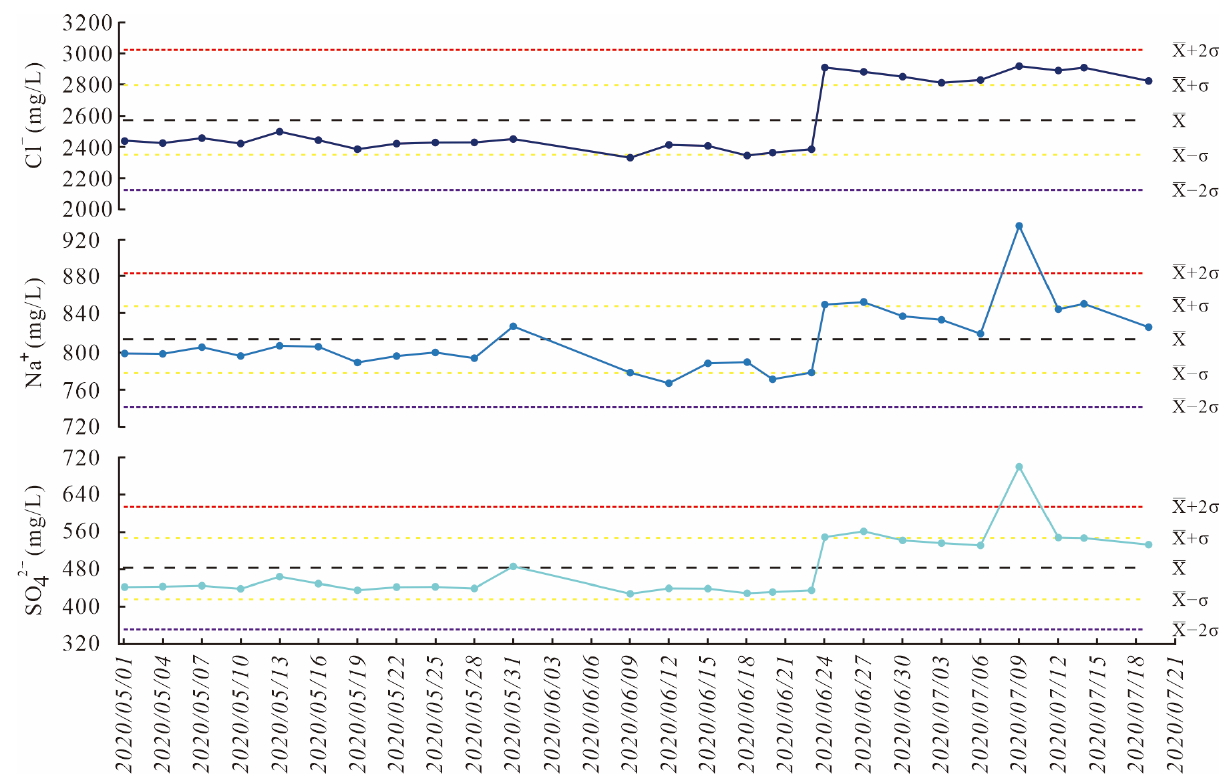
Figure 11. Time series diagram of AK spring ion detection results.